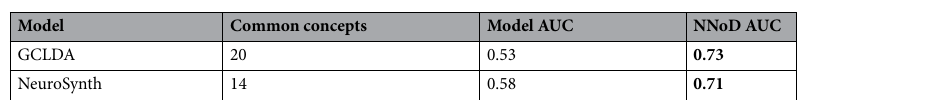
Table 1. Models performance comparison on original concepts common with NeuroSynth or